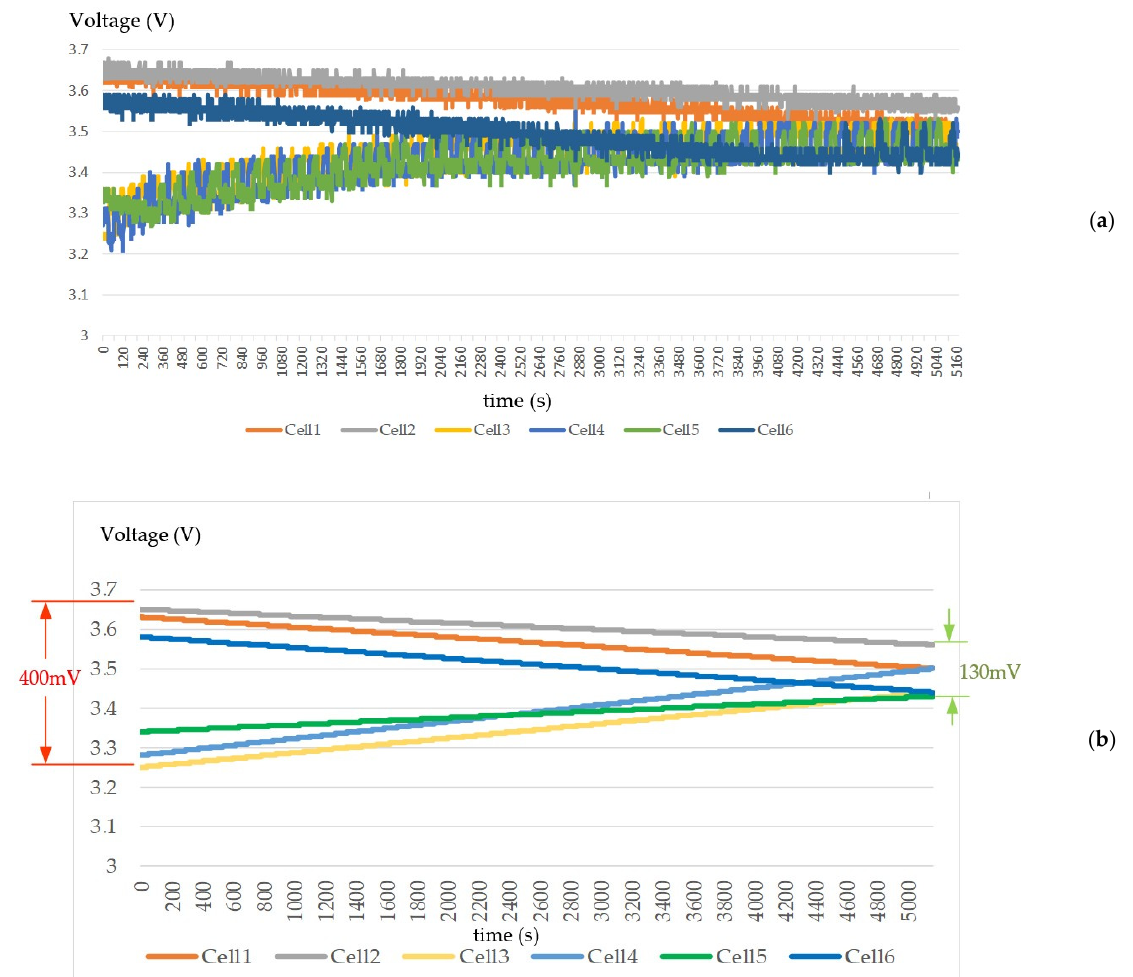
Figure 12. Measured results of each cell’s voltage using pack-to-cell procedure ( a ) actual hardware measurements ( b ) processed results.